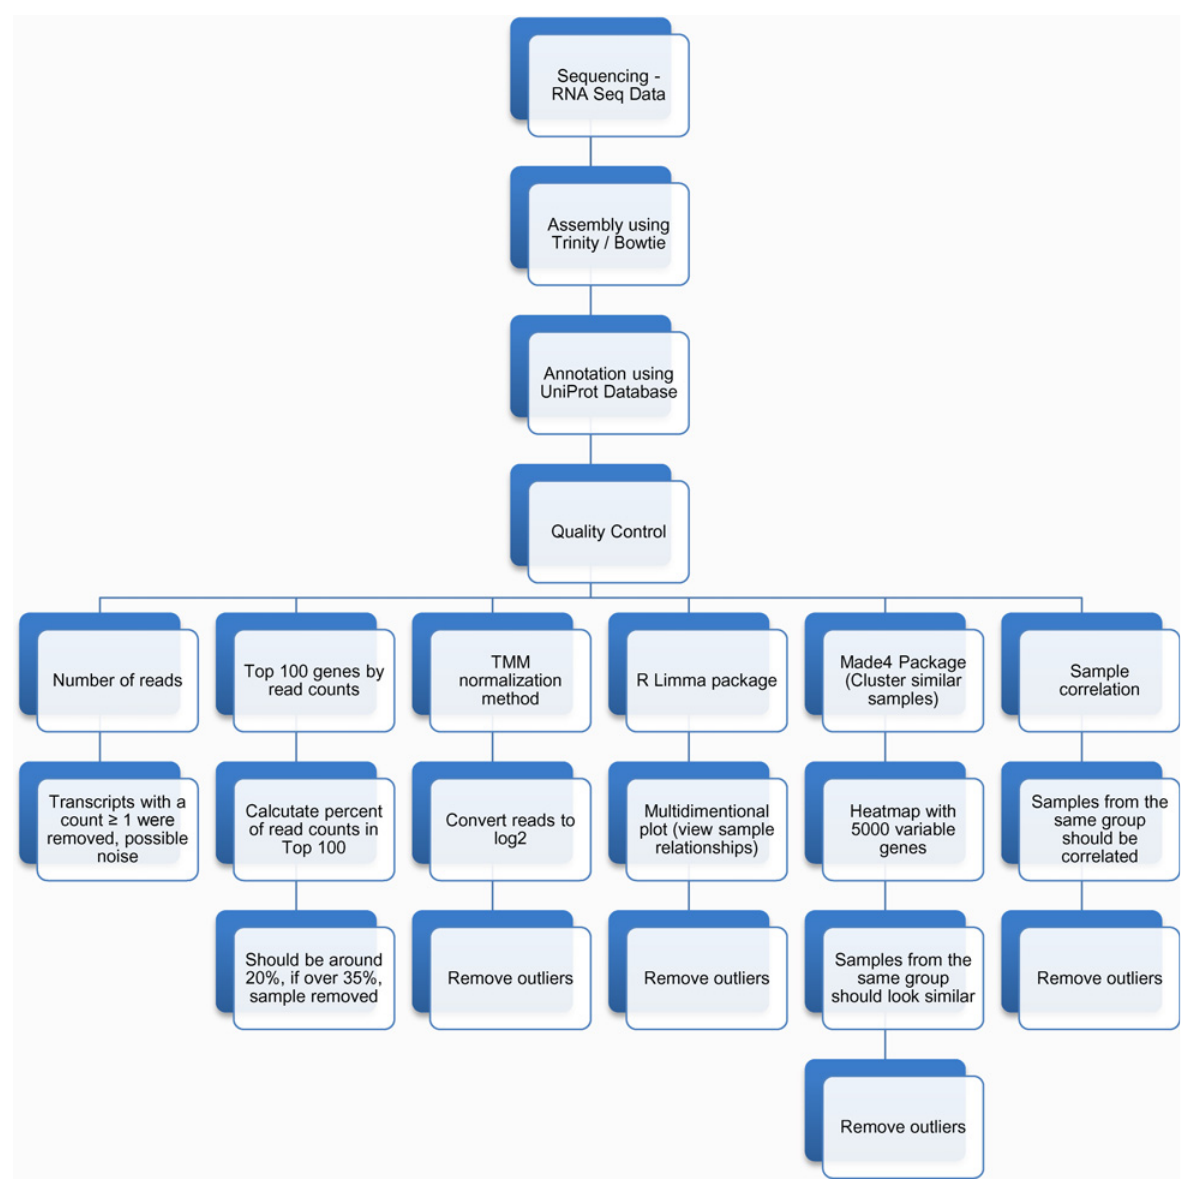
Fig 2. Flowchart of the Betula papyrifera transcriptome analysis. Based on the data, we removed three samples as